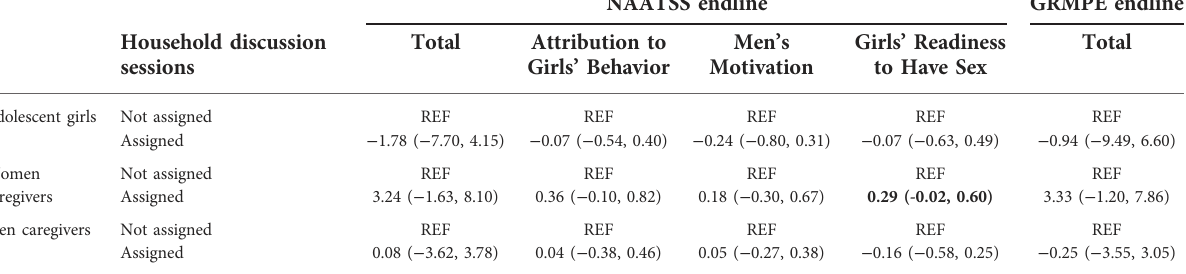
Bold values indicate p